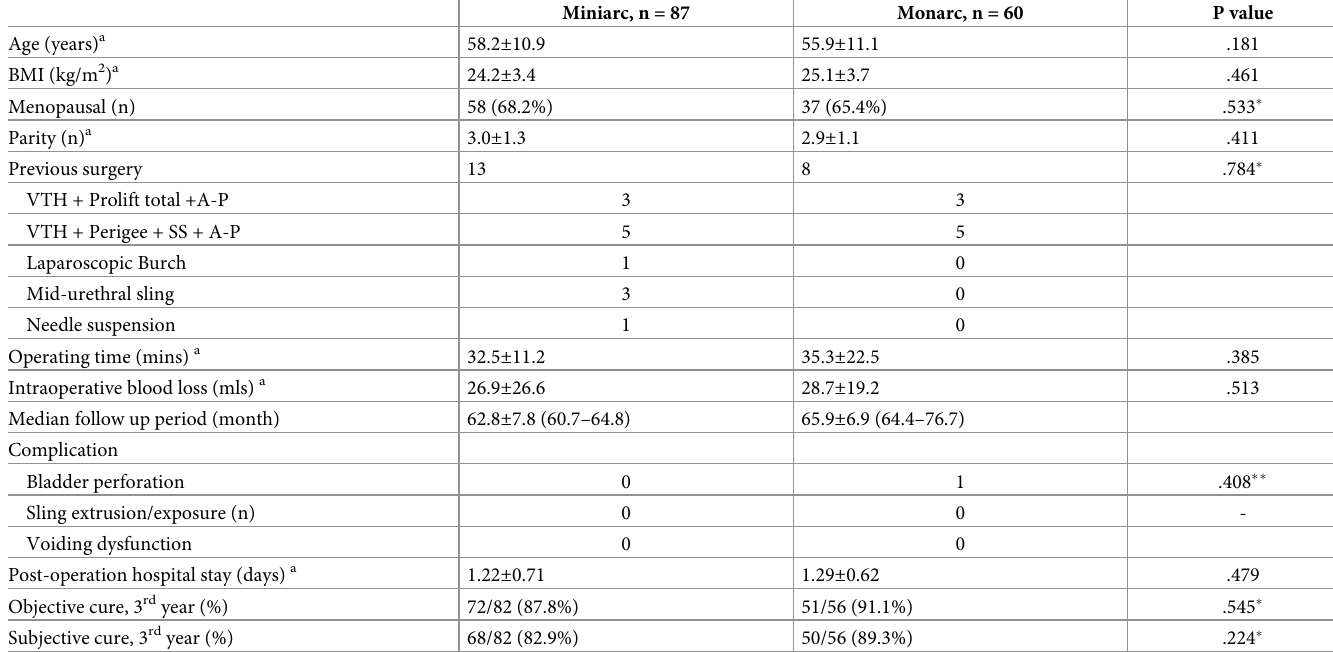
Table 1. Patient